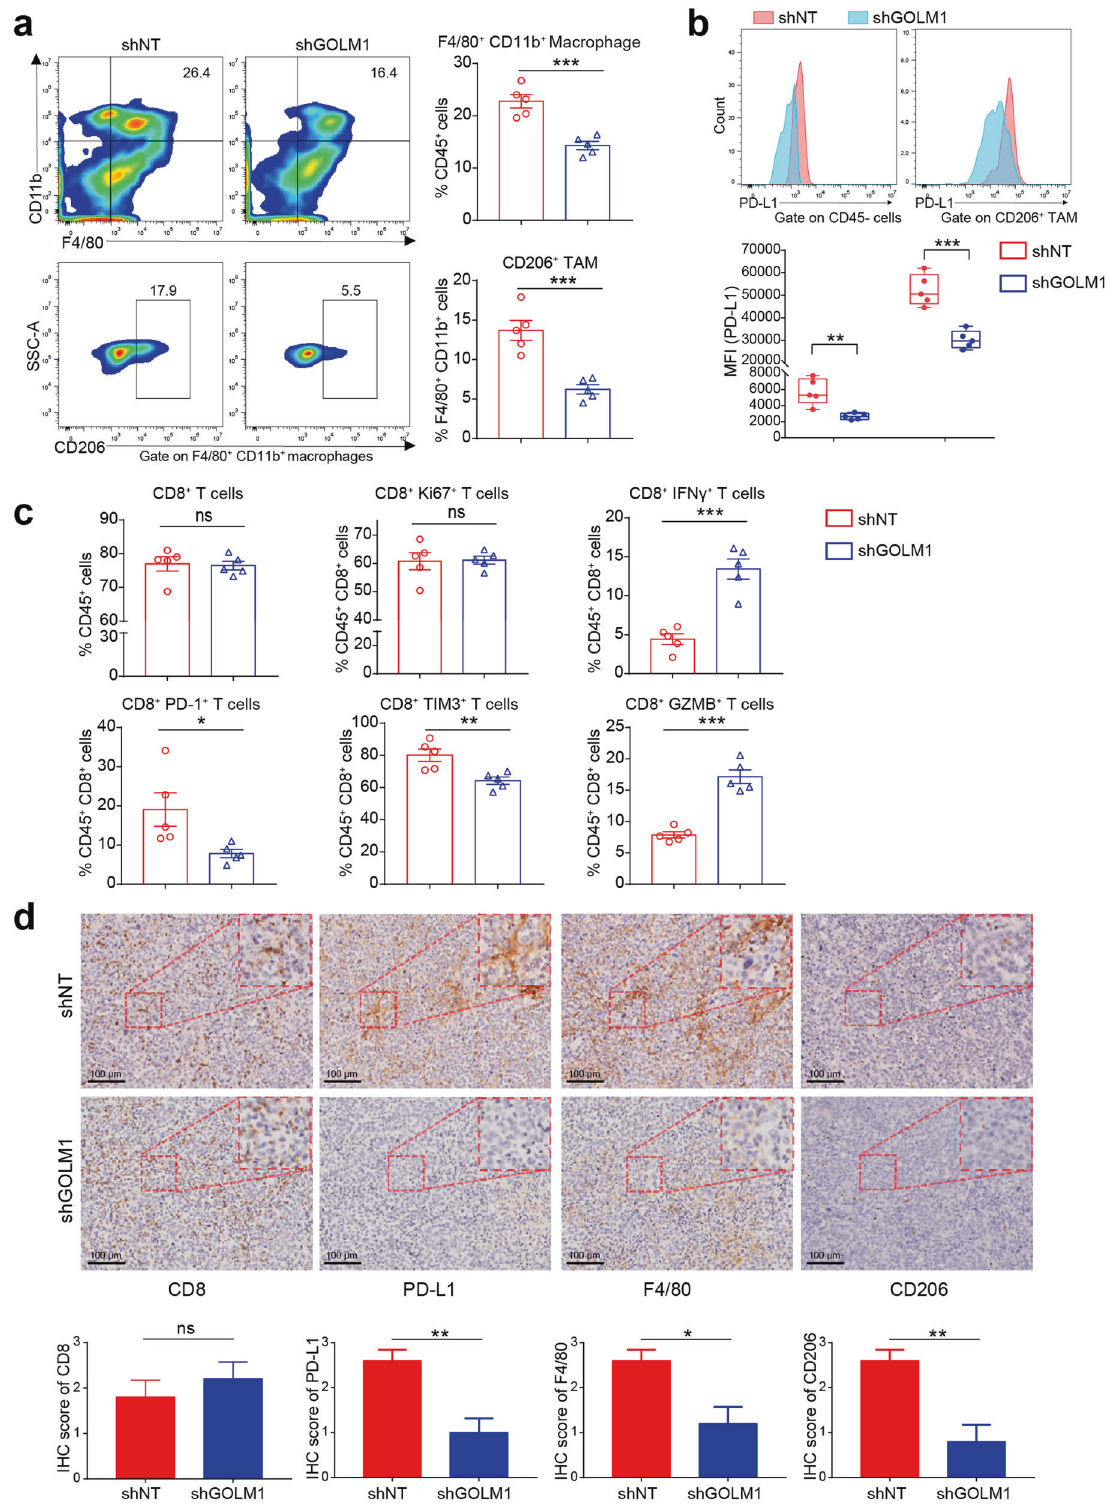
Fig. 2 GOLM1 promotes TAM in fi ltration and PD-L1 expression on TAM in HCC. a Flow cytometric analysis of the in fi ltrated macrophages (F4/ 80 + CD11b + ) and TAMs (F4/80 + CD11b + CD206 + ) in tumor tissues of subcutaneous implantation models of C57BL/6 mice with Hepa1-6-shNT or Hepa1-6-shGOLM1 cells ( n = 5). b Flow cytometric analysis of PD-L1 expression in tumor and stromal cells (CD45 − ), and TAMs (F4/ 80 + CD11b + CD206 + ) in tumor tissues of subcutaneous implantation models of C57BL/6 mice ( n = 5). c Flow cytometry analysis of the number and functional state of CD8 + T cells in the subcutaneous implantation models of C57BL/6 mice. Inhibitory receptors (PD-1 and TIM-3), the ability to produce effector cytokines (IFN- γ and GZMB), and proliferation (Ki67) of CD8 + T cells were detected to evaluate the functional state of T cells ( n = 5). d The densities of CD8, PD-L1, F4/80, and CD206 were consistently observed by IHC staining. The quanti fi cation is shown on the bottom panel ( n = 5). * P < 0.05, ** P < 0.01, *** P < 0.001, ns: no signi fi